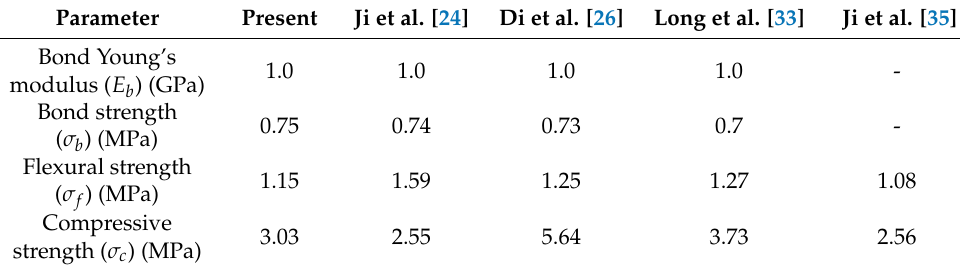
Figure 5. Typical simulation results: ( a ) stress–deflection curve in three-point bending test; ( b ) stress–strain curve in uniaxial compressive test. Points A and B indicate two arbitrary selected points to derive the simulated Young’s modulus ( E s ). Point C corresponds to the maximum load ( P max ) for calculating the compressive ( σ c ) and the flexural strength ( σ f ) in Equations (19) and (20), respectively. Table 2. Simulated flexural strength in different DEM